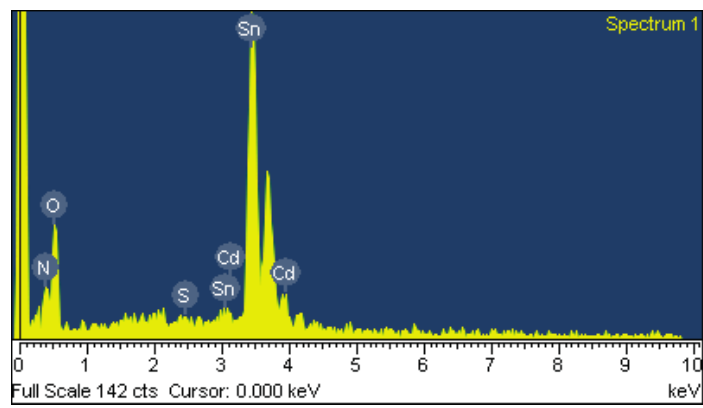
Figure 4. SEM image of the tin oxide doped cadmium sulfide film.